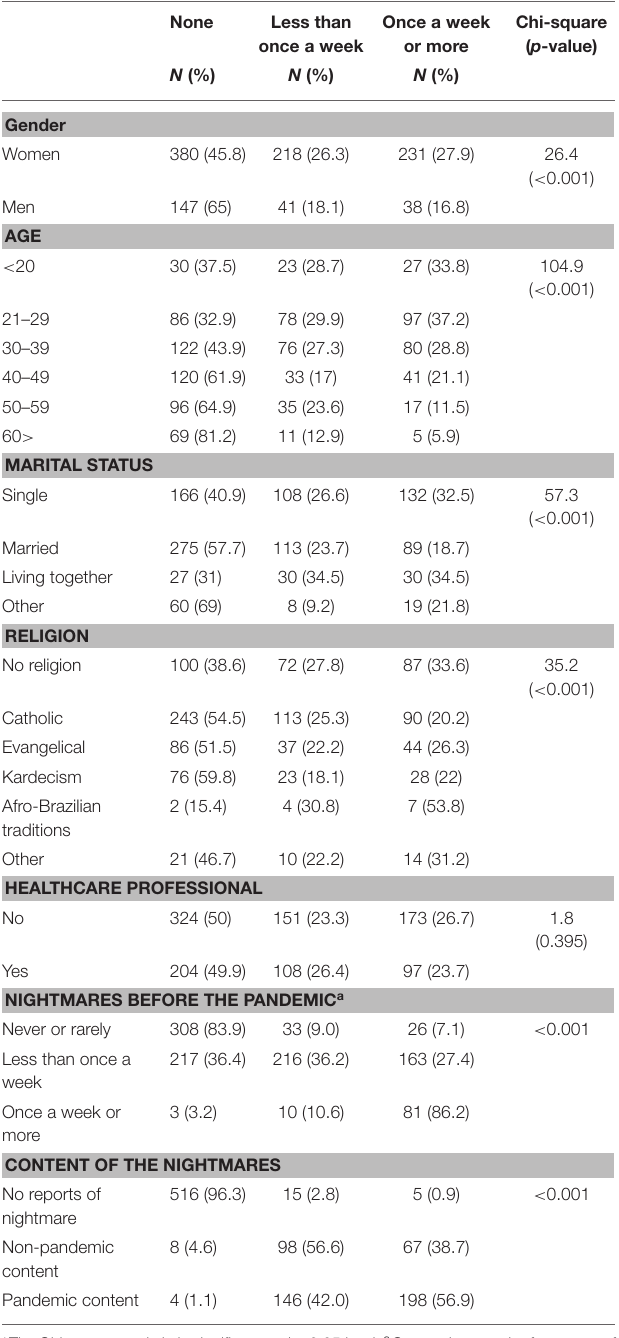
TABLE 2 | Nightmares during the pandemic by sample’s characteristics ( N = 1,057).